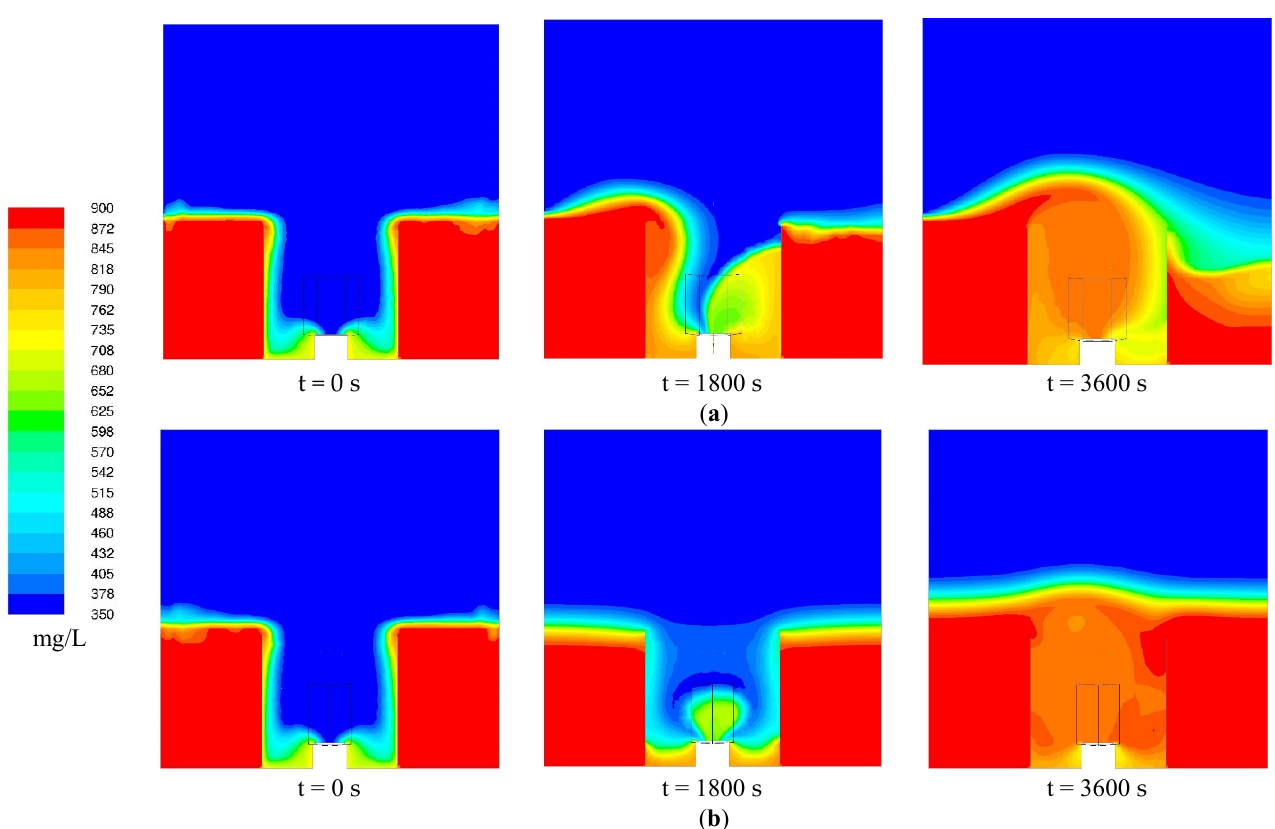
12 of 15 Figure 8. Distribution of mineralization ( a , c ) and vector field of flow velocity ( b , d ) of withdrawn water in the area of the intake head with bottom barriers at the flow rate of the withdrawn water through one head of 2 m 3 /s ( a , b ) and 4 m 3 /s ( c , d ). In this case, one should take into account the fact that total water mineralization is linearly related (R2 ~ 0.98) with the main limiting indicator of water quality in this water intake − hardness of withdrawn water. As follows from Figure 8, an increase of the intake flow rate provides more effective breaking of the density jump layer and accordingly lower mineralization and hardness of the withdrawn water. The mineralization of the withdrawn water at the intake flow rate of 4 m 3 /s becomes more than half as much as the mineralization at the flow rate of 4 m 3 /s. The effect of flow instability on the quality of the withdrawn water is shown in Figure 9. The figure illustrates the temporal evolution of the water mineralization field in the presence of bottom barriers at the rate of water flow through a single water intake head of 4 m 3 /s in the case when the velocity of the river flow varies linearly from 0 m/s to 0.1